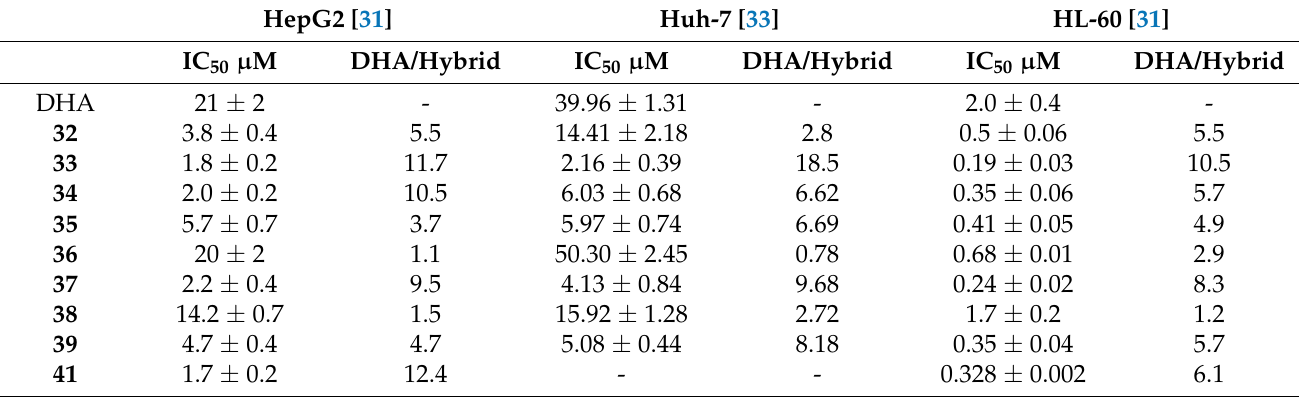
Table 3. IC 50 values were determined from the dose-response curves using MTT assay after 72 h incubation time. Results are expressed as the mean of three independent experiments ± SD. DHA/Hybrid ratio meant the ratio of the corresponding IC 50